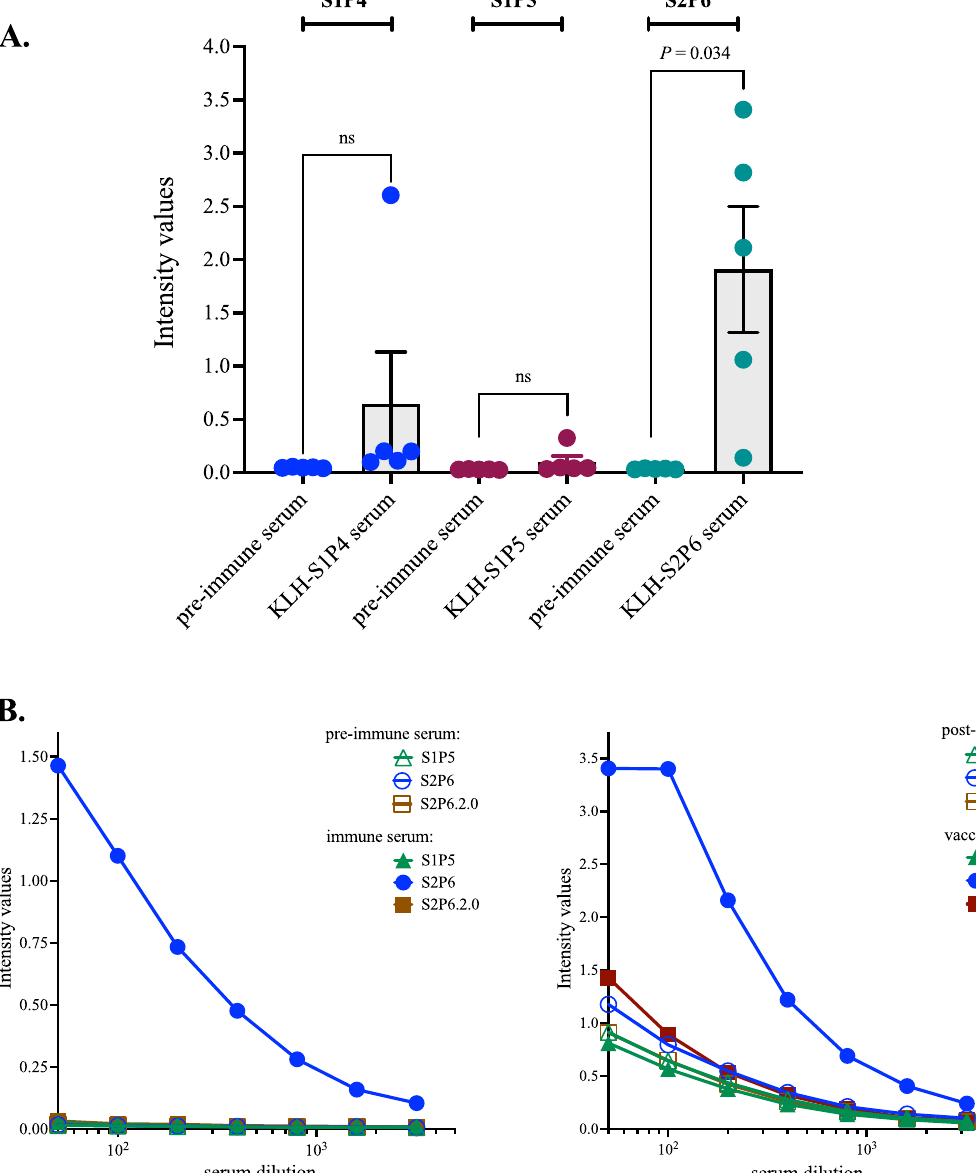
Figure 7. Immune reactivity of mouse antibodies raised against B-cell epitope peptides. In ( A ), serum samples from mice ( n = 5) that received the KLH-peptide conjugates were assessed for peptide-reactive antibodies through peptide-based ELISA using the synthetic S1P4, S1P5, and S2P6 peptides (200 ng.mL −1 ) for antigen- based antibody capture. The pre-immune serum of each individual that received the KLH-peptide conjugates was tested. The intensity values of serum samples at dilution 1:50 were measured at O.D. 450 nm. Paired t tests between pre-immune serum and KLH-peptide serum were performed (ns: non-statistically significant, p > 0.05). The results are representative of two independent experiments. In ( B ), synthetic peptide-based ELISA using the S2P6 and S2P6.2.0 peptides (200 ng.mL −1 ) for peptide-based antibody capture. At the left, pre-immune and immune serum samples of an immunized mouse with KLH-S2P6 conjugates. At the right, serum samples from a COVID-19 immune subject collected after recovery (post-infection) and after injection of a single dose of comirnaty vaccine (vaccination). Synthetic S1P5 peptide served as negative peptide control. The intensity values of serum samples in a dose-curve response were measured at O.D. 450 without prior evidence of infection or with confirmed prior COVID-19 infection 36 . Indeed, the design of a such serological assay would be of interest to test for anti-spike antibody levels before administration of vaccine booster doses. To our knowledge, it is not yet known whether the SARS-CoV-2 spike residues 616/644 and 1138/1169 con- tribute to the protective efficacy of Pfizer-BioNTech COVID-19 vaccine comirnaty 23,31–34,37,38 . There is some evidence that potent neutralization of SARS-CoV-2 requires both spike conformational changes and receptor